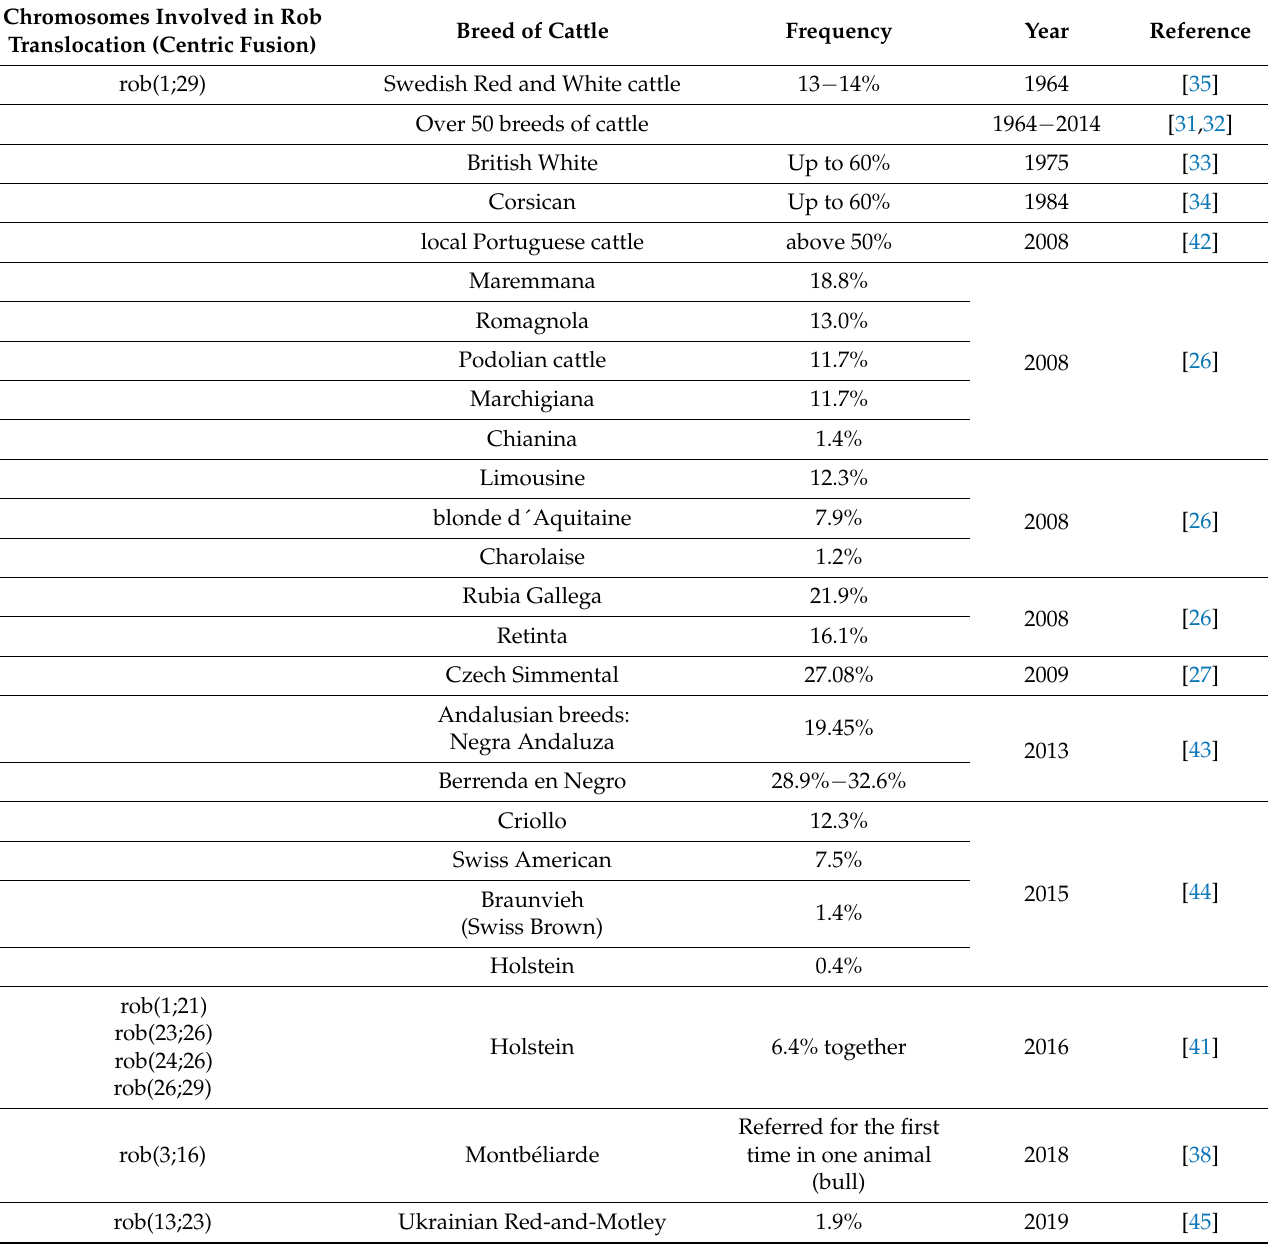
Table 1. The frequencies of Robertsonian translocation carriers in some breeds of cattle. Chromosomes Involved in